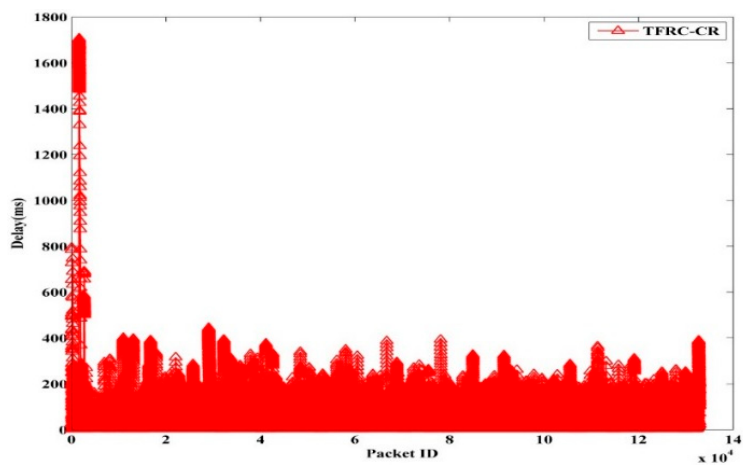
Figure 15. TFRC-CR Packet Delay.